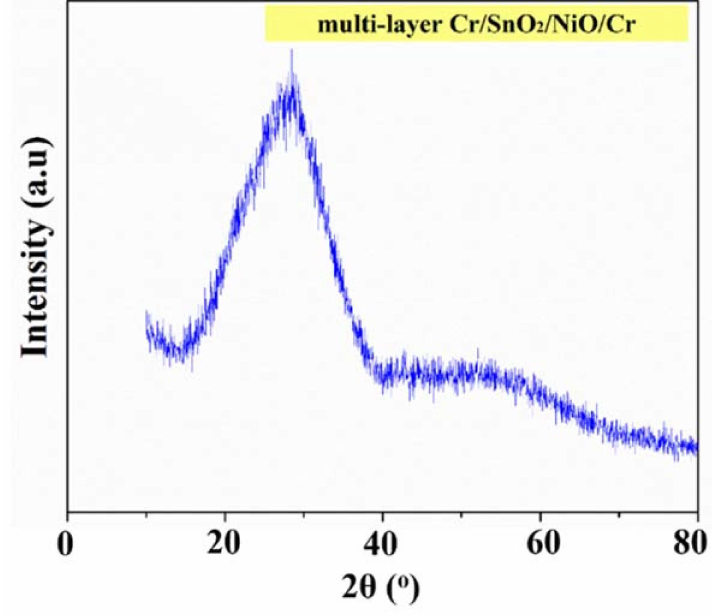
Figure 3. XRD pattern of the multi-layer Cr/SnO 2 /NiO/Cr coatings. Representative FESEM images of the coatings are shown in Figure 4. All coatings possess dense and uniform surfaces with no visible cracks or pinholes and good adhesion (determined by a tape test method) to the underlying substrate. Moreover, the figures illustrate that the layers consist of nanocrystals, which are spherical in